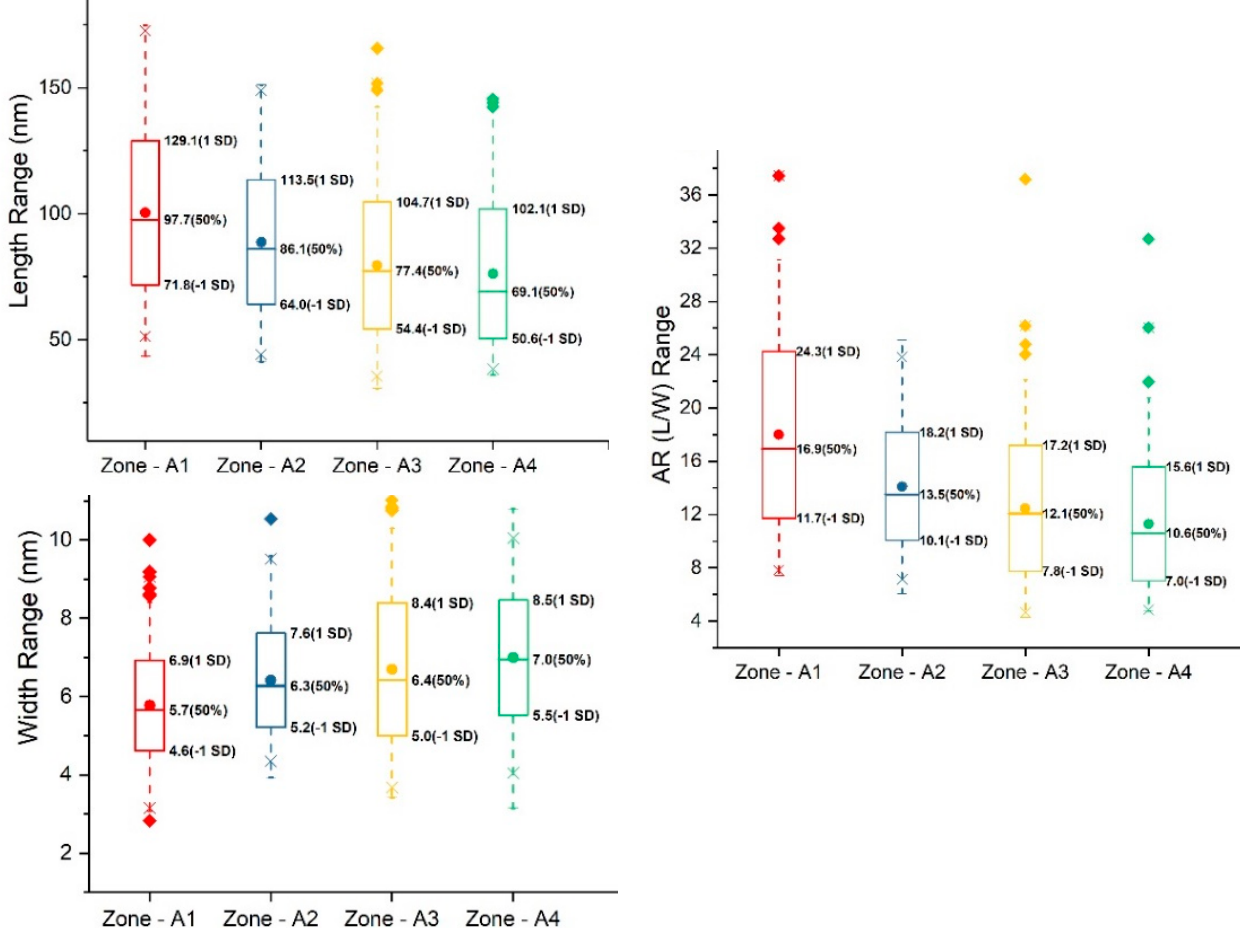
Figure 4. Box plots of length, width and aspect ratio (L/W) distribution of stained.CNCs at zones A1 to A4 with deceasing stain-depth. The line and dot in the box are the median and mean, respectively. The values of the median and one standard deviation (SD) above and below the mean are labelled to the left of boxes.